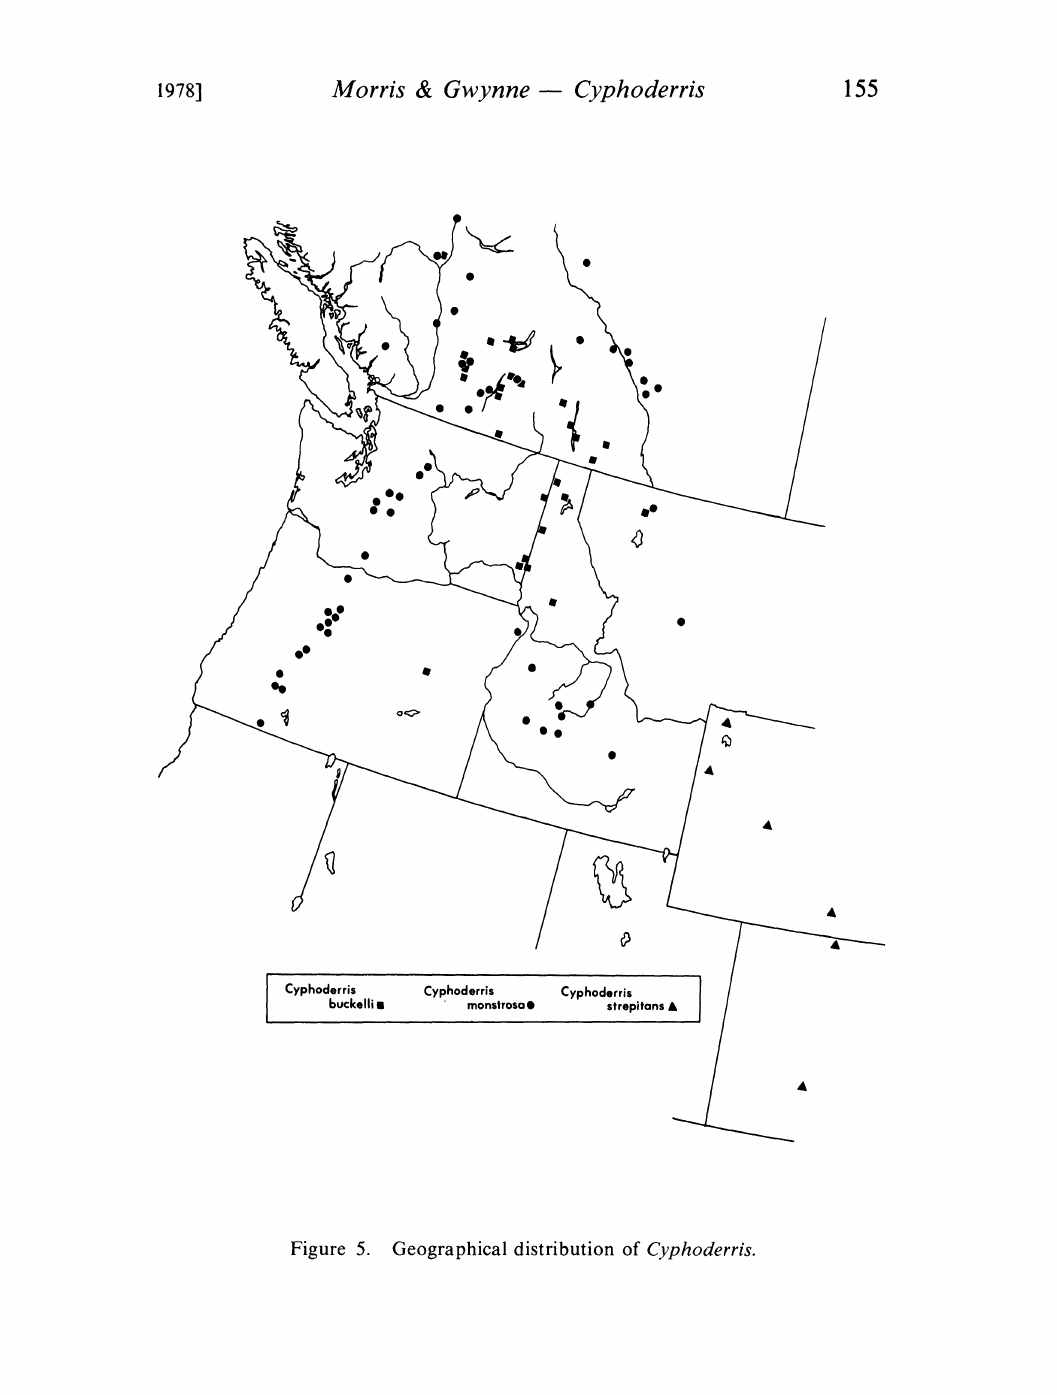
Figure 5. Geographical distribution of